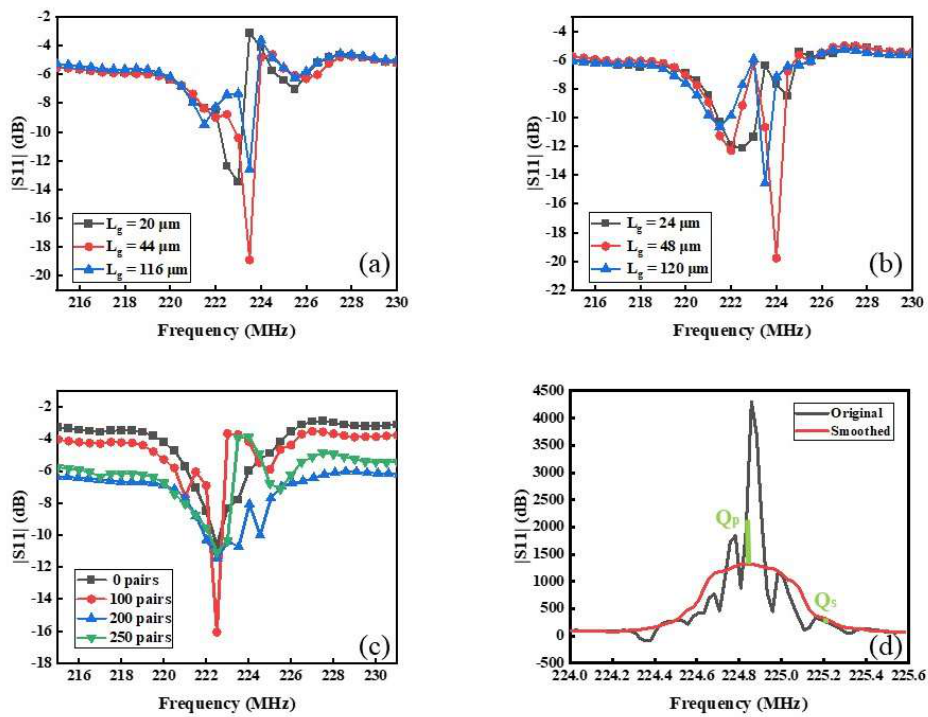
Figure 5. S11 parameter curves of the SAW devices with three kinds of L g , ( a ) short-circuit reflector and ( b ) open-circuit reflector. ( c ) S11 parameter curves of the SAW devices with four kinds of reflecting grid logarithm. ( d ) The group delay algorithm calculates Q value.